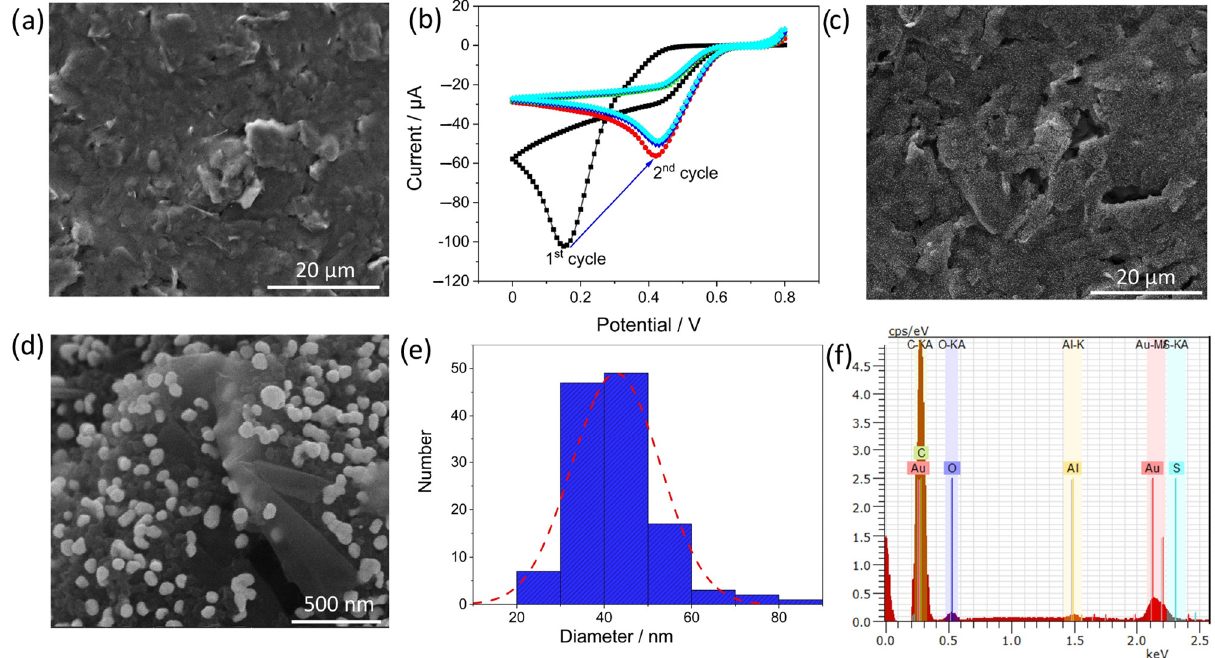
Figure 3. SEM images of ( a , c ) bare SPCE and SPCE after electrodeposition, ( b ) shows the electro- chemical deposition of Au nanoparticles by CV in 0.01 M HAuCl 4 with distilled water as supporting electrolyte and scan rate of 0.075 V/s for five cycles, ( d ) magnified SEM image showing the distribu- tion of Au nanoparticles on the surface, ( e ) Histogram for the size distribution of Au on the surface evaluated from ImageJ and ( f ) shows the corresponding EDX spectra of EdAu/SPCE.